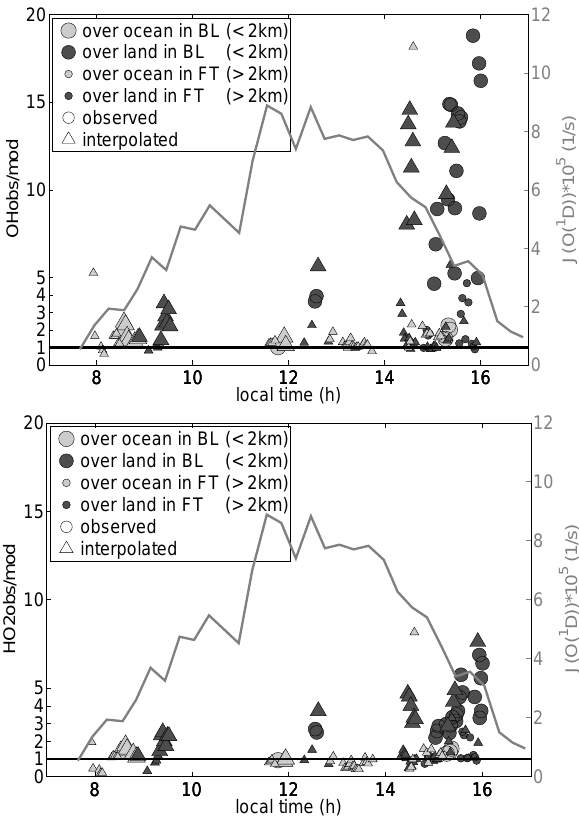
Fig.10. Comparisonofmeasurementsandmodelresultsasafunctionoftime,dividedintotwoaltituderegions: Fig. 10. Comparison of measurements and model results as a boundary layer (BL) < 2 km and free troposphere (FT) > 2 km. function of time, divided into two altitude regions: boundary layer (BL) < 2km and free troposphere (FT) > 2km.